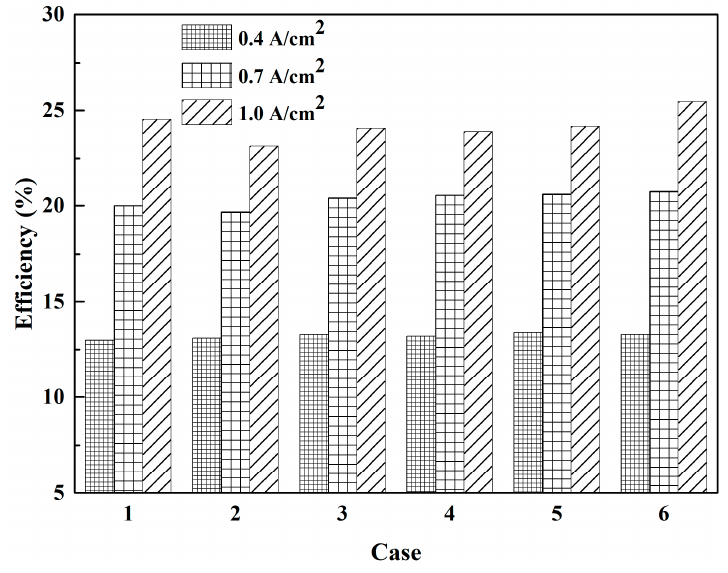
Figure 9. Effects of inlet RH on PEMFC efficiency at various current densities.